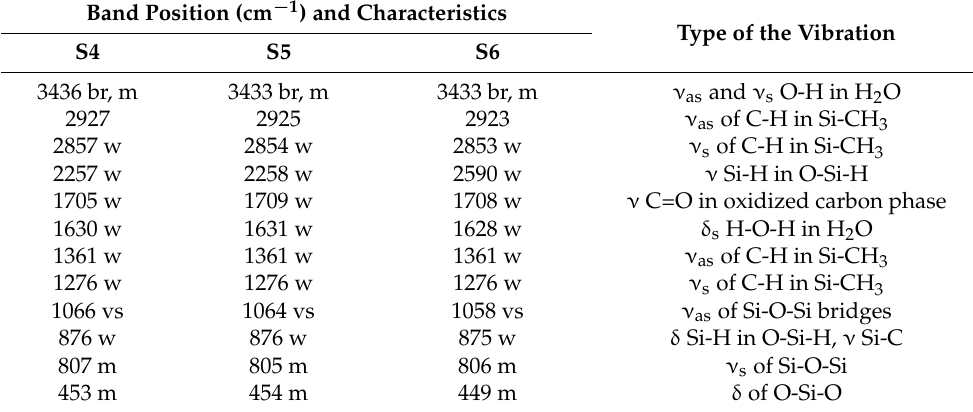
Table 2. Detailed FT-IR spectra analysis for the silicon oxycarbide materials (S4–S6 samples), abbrevi- ations used as in Table 1.